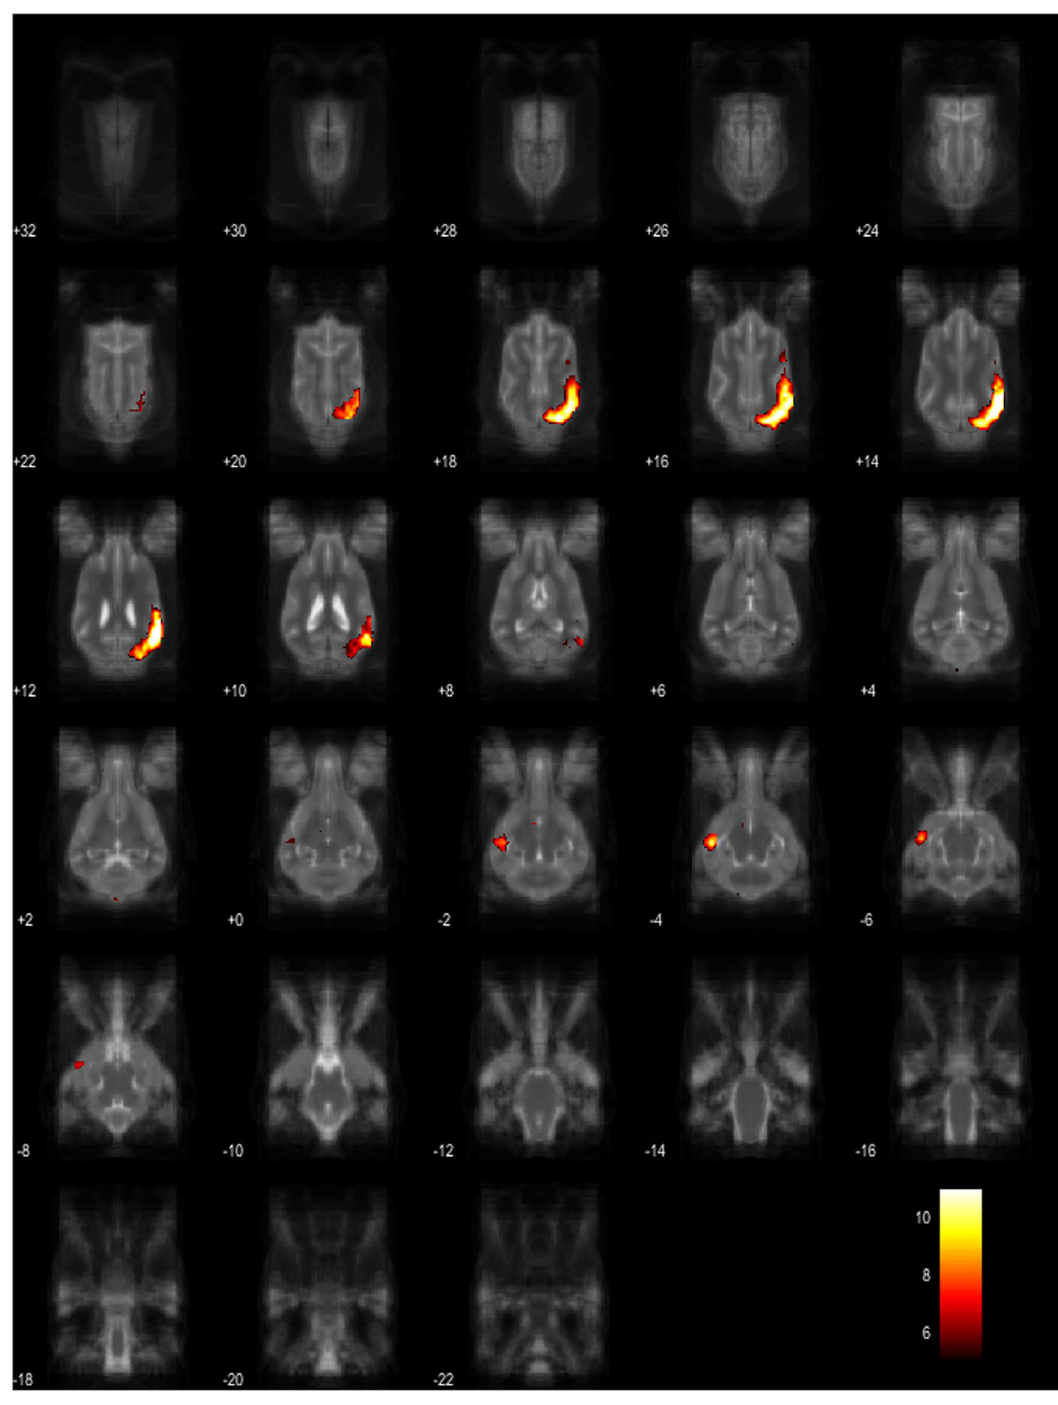
Figure 18. Resting-state network component O from the 15 component gICA. We report the results with a voxel-wise FDR corrected p < 0.001 and cluster treshold of FDR corrected p < 0.005. gICA components are presented as thresholded T-maps, corrected for multiple comparisons, overlaid on the Nitzsche atlas 15